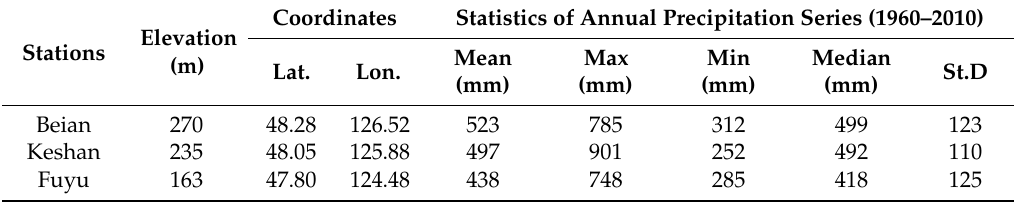
Table 2. Statistical characteristics of precipitation in the Wuyuer River